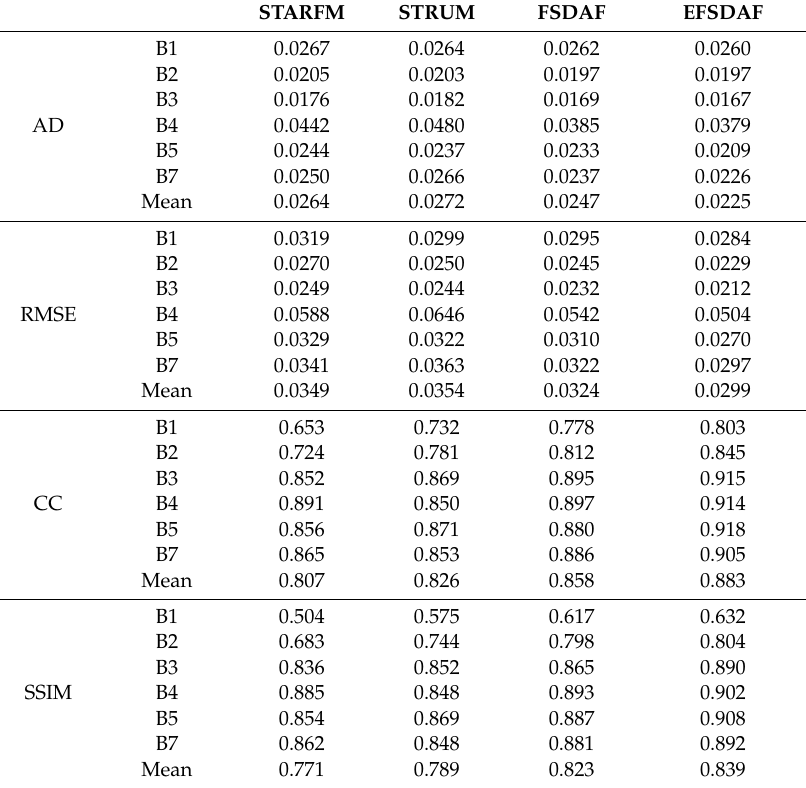
Table 1. The quantitative assessment of the Landsat-like images by STARFM, STRUM, FSDAF, and EFSDAF in dataset 1.